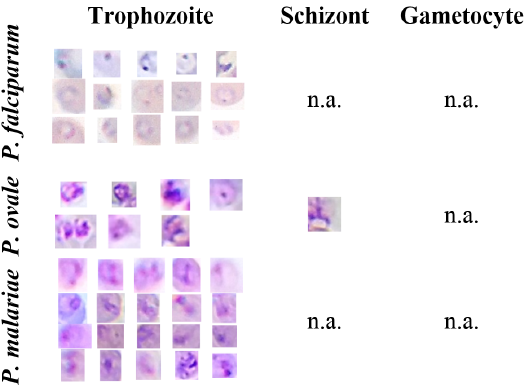
Figure 12. Examples of false negatives’ candidates for different species and life stages after segmentation and filtering.